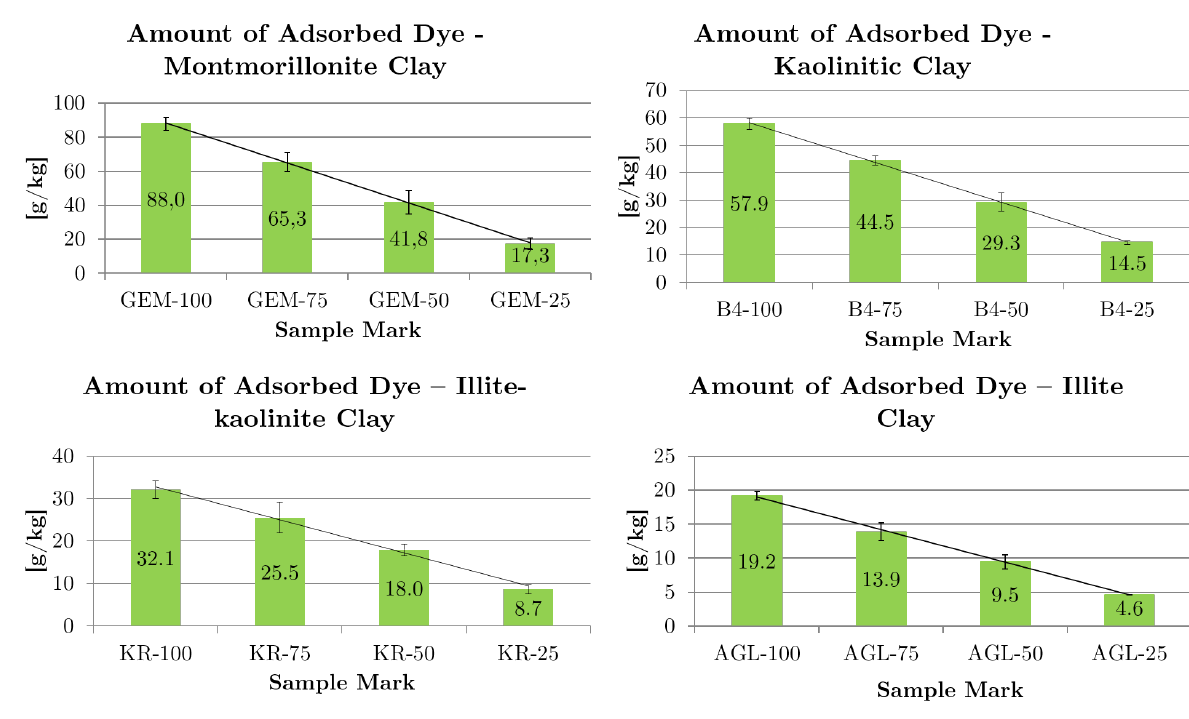
Figure 7. Amount of adsorbed methylene blue dye by clay.